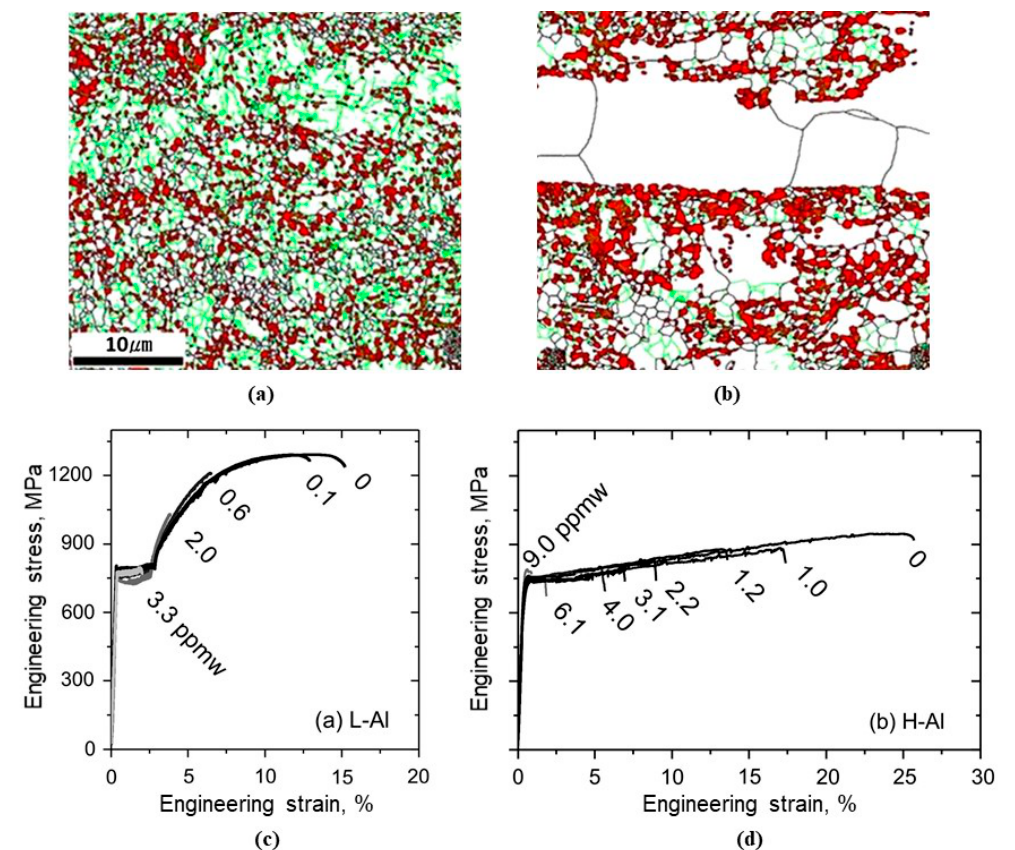
Figure 8. EBSD phase maps for BCC (white) and FCC (red) of ( a ) low–Al/medium-Mn steel (L–Al: Fe–0.12C–4.6Mn–0.55Si–1.1Al, in wt pct) and ( b ) high-Al/medium-Mn steel (H–Al: Fe–0.12C–5.8Mn–0.47Si–3.1Al, in wt pct). ( c ) Engineering stress–strain curves of low-Al and ( d ) high-Al alloys pre-charged with an H concentration of 0 to 9 ppm, tested at a slow strain rate of 10 5 s − 1 . In ( a , b ), green and black lines indicate low-angle (misorientation of 2–15 ◦ ) and high-angle (misorientation >15 ◦ ) boundaries, respectively. Reproduced from Reference [48], with permission from Elsevier.